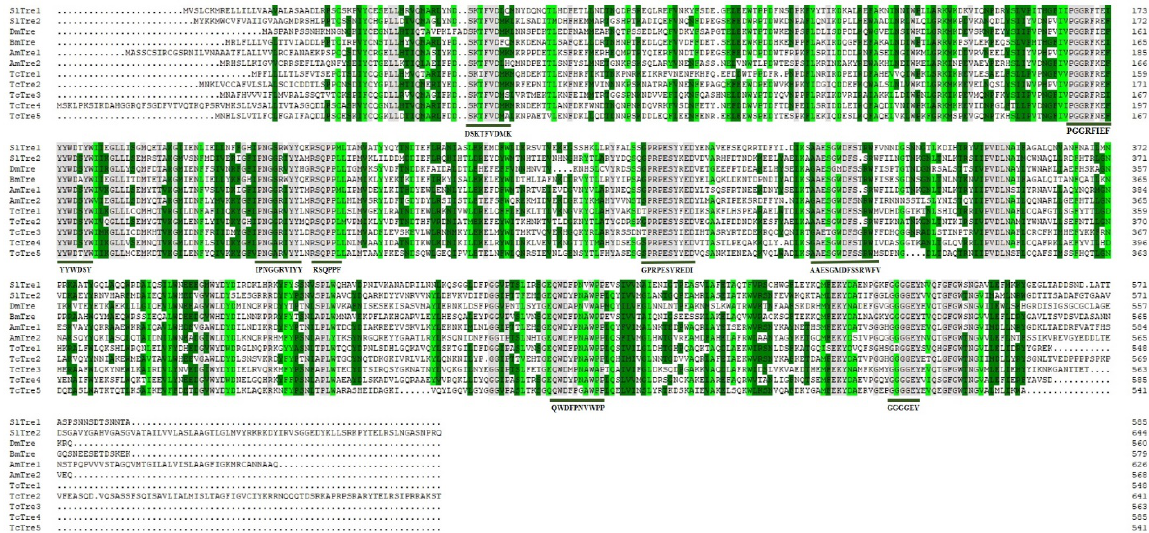
Figure 1. Amino acid sequence alignment of S. litura trehalase with its homologues in other species. Identical amino acids were highlighted in grey, and similar amino acids were highlighted in dark green and light green. Trehalase signature regions were indicated by the dark green solid lines. Drosophila melanogaster (Dm); Bombyx mori (Bm); Apis mellifera (Am); Tribolium castaneum (Tc); Spodoptera litura (Sl).